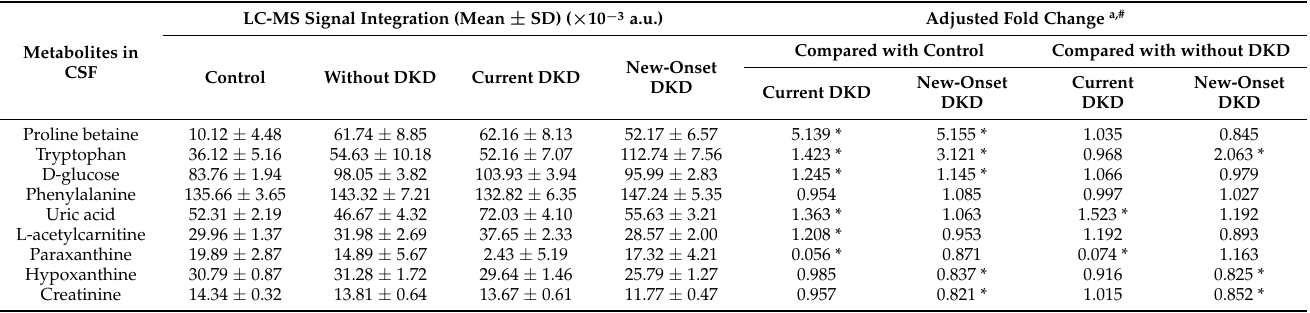
Table 2. Altered metabolites in the CSF samples of the type 2 diabetic patients with DKD, compared to patients without DKD or the control participants.